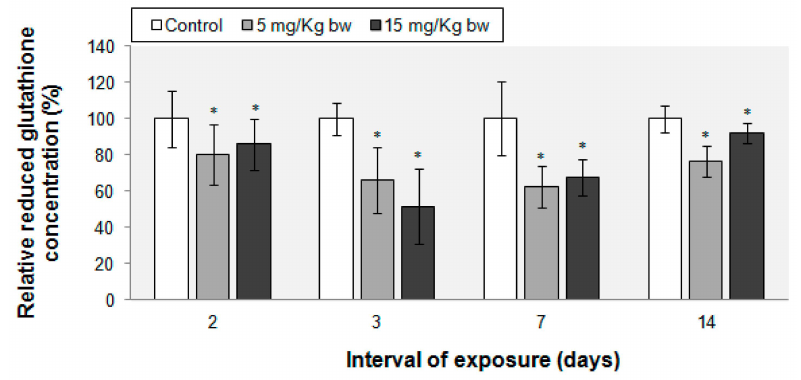
Figure 5. Reduced glutathione concentration in murine lung tissue after exposure to IONPs-PM. Data represent the relative mean ˘ standard deviation of seven animals per group. The values are expressed in percentages relative to control (100%). The difference between the treated group and the control group was significant when * p < 0.05, α (significance level) = 0.05.